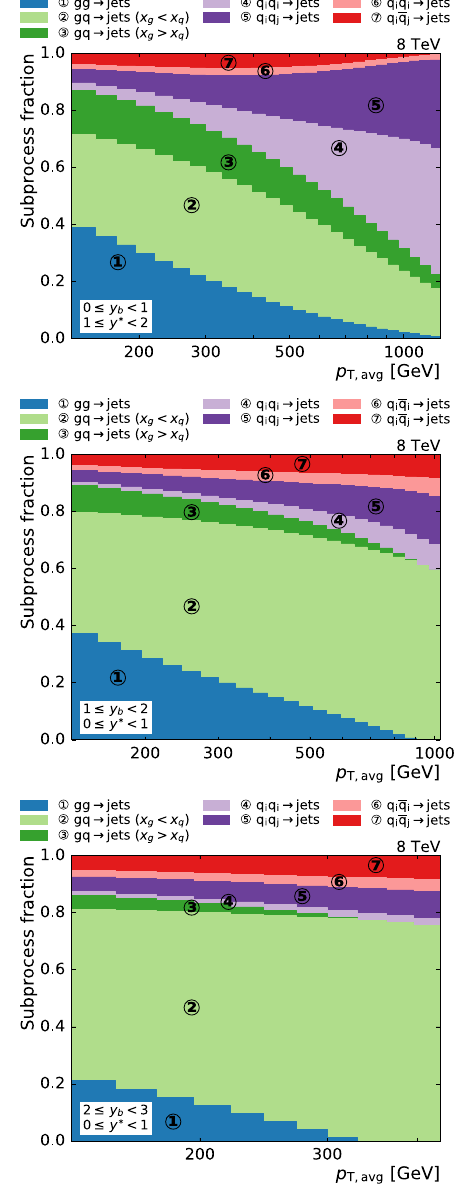
of the true momentum over the whole p T range. Jet energy corrections (JEC) are derived from the simulation, and are confirmed with in situ measurements of the energy balance of dijet, photon+jet, and Z boson+jet events [22,23]. After applying the usual jet energy corrections, a small bias in the reconstructed pseudorapidity of the jets is observed at the edge of the tracker. An additional correction removes this